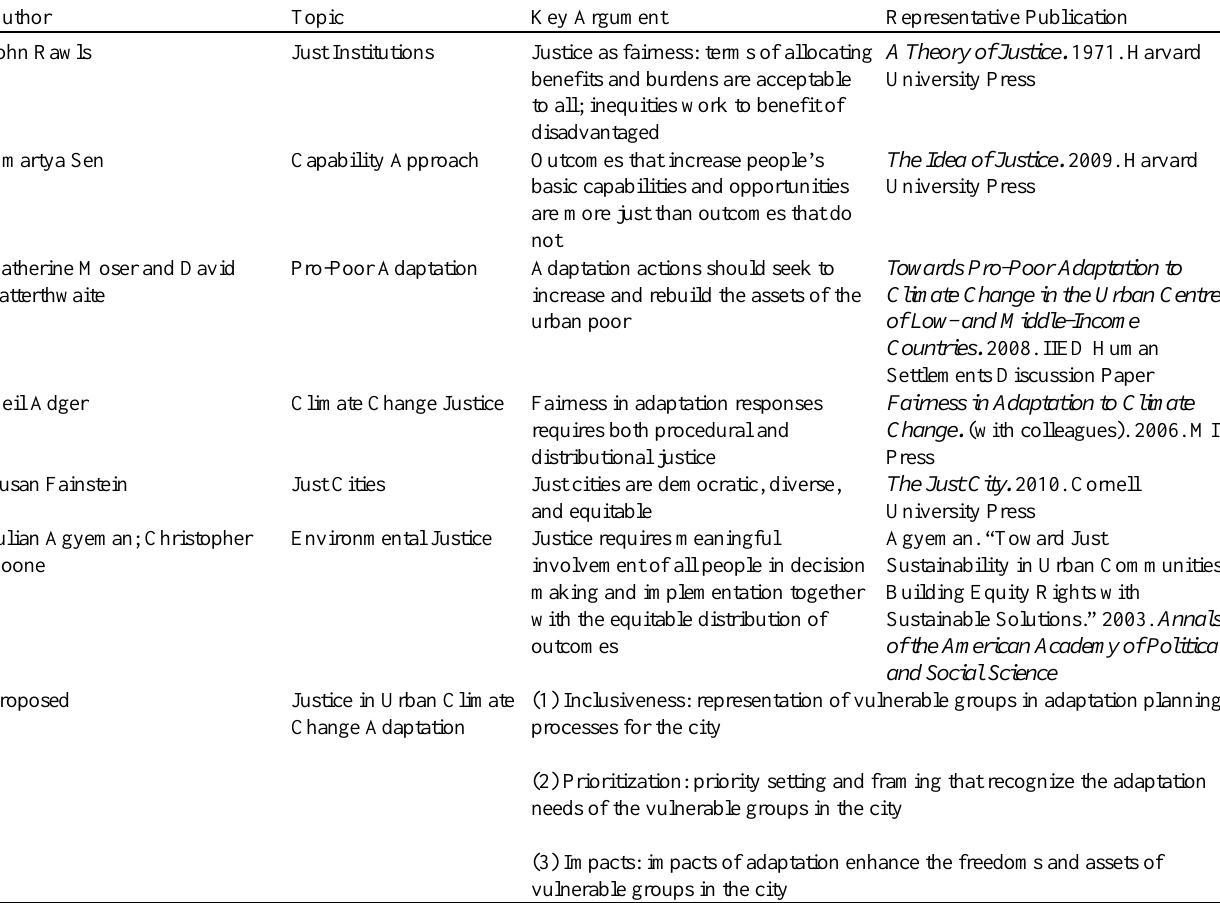
Table 1 . Summary of major contributions to the examination and definition of justice relevant to urban climate change adaptation and proposed criteria for justice in urban